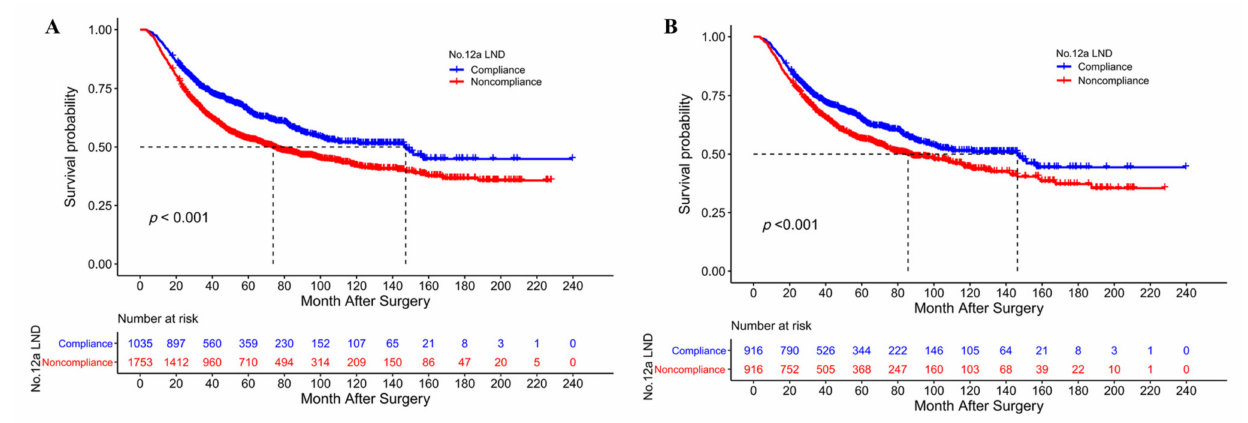
Figure 2. ( A ) The overall survival curves of No. 12a LND compliant and noncompliant patients after a D2 gastrectomy before PSM; ( B ) The overall survival curves of No. 12a LND compliant and noncompliant patients after a D2 gastrectomy after